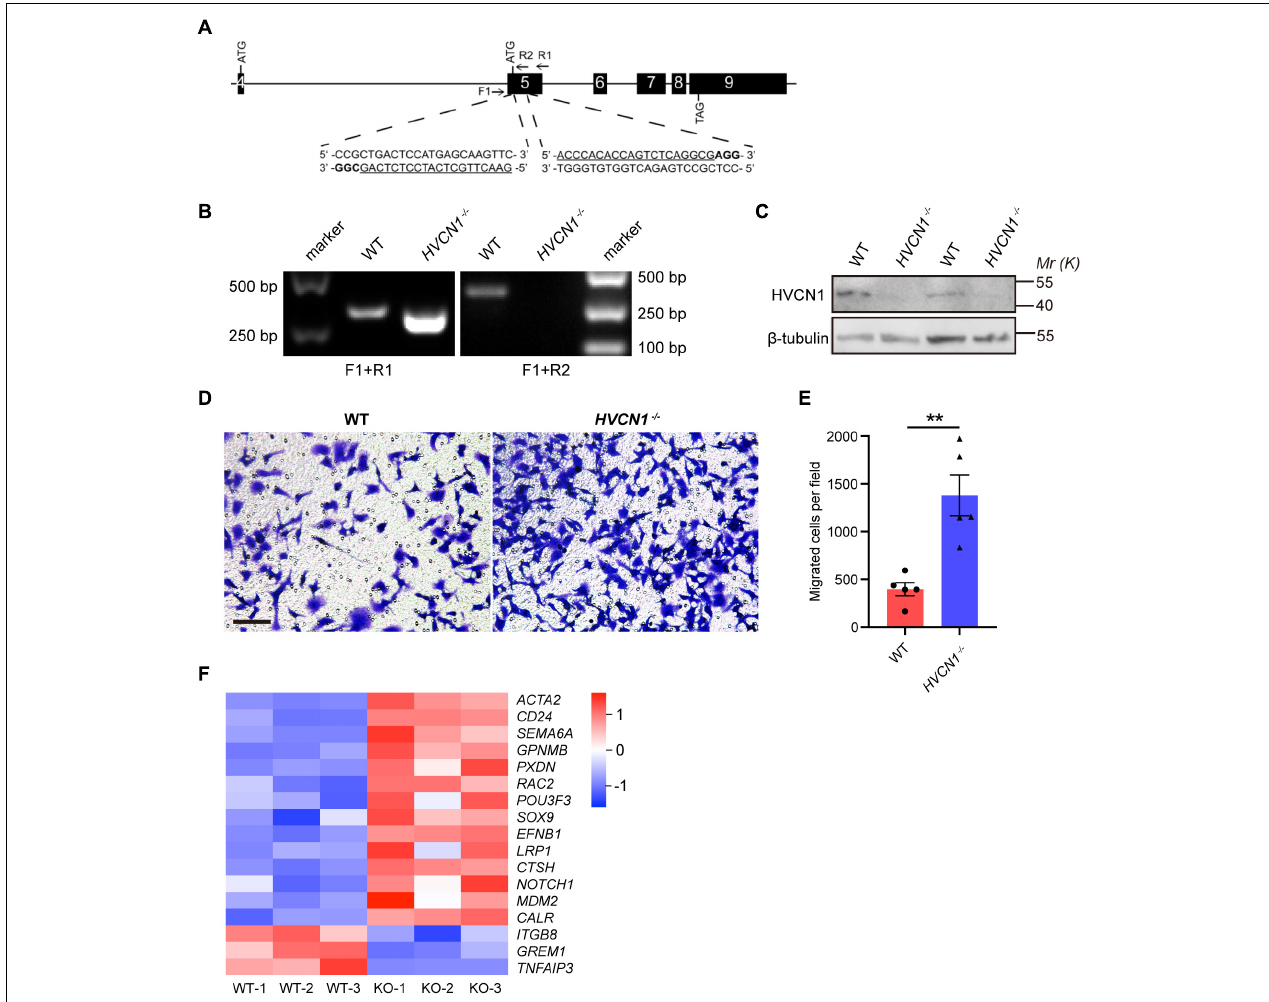
FIGURE 4 | HVCN1 genetic deletion in vitro promotes cell migration. (A) HVCN1 knockout strategy by CRISPR/Cas9 in Hela cells. Black boxes, exons; line, introns; Arrows, primers for PCR detection; Underlined, sgRNA targeted sequences; Bold, protospacer adjacent motif (PAM). (B) Genomic PCR products of WT and HVCN1 − / − Hela cells. The position of primers is shown in (A) . (C) Western blot images of HVCN1 in WT and HVCN1 − / − Hela cells. (D) Representative images of transwell assay. Scale bars = 100 µ m. (E) Quantification of transwell assay ( n = 5). (F) A heatmap of migration related gene expression changes between WT and HVCN1 − / − 293T cells by RNA-seq. Data are presented as mean ± SEM. Statistical tests: unpaired two-tailed t -test (E) ; ** p <